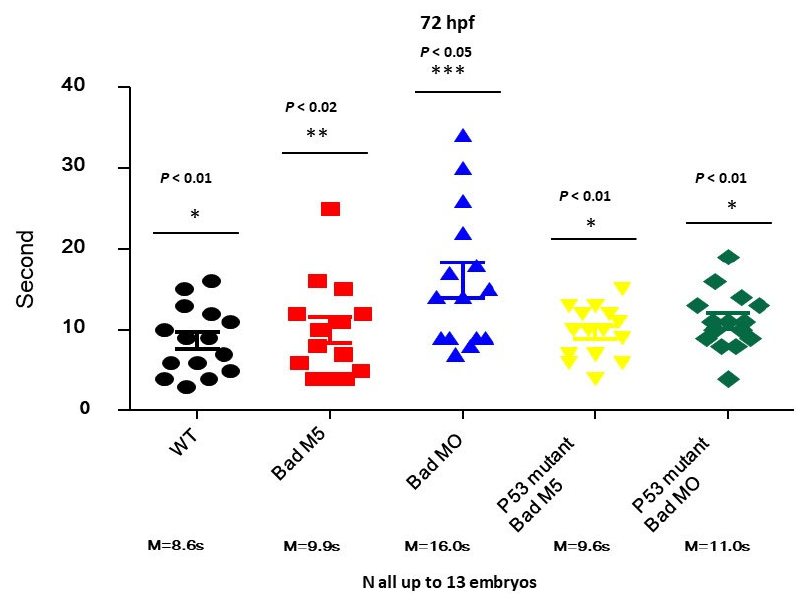
Figure 7. Identification of brain functions through monitoring of swimming behavior at 72 hpf. Swimming speed over a limited length was monitored for different fish lines with and without Bad knockdown. The wild-type with Bad-MO group was slower than the other groups by approximately 5 s at 72 hpf. All data were analyzed using either paired or unpaired Student’s t -tests, as appropriate. * p < 0.01; ** p < 0.02; *** p <